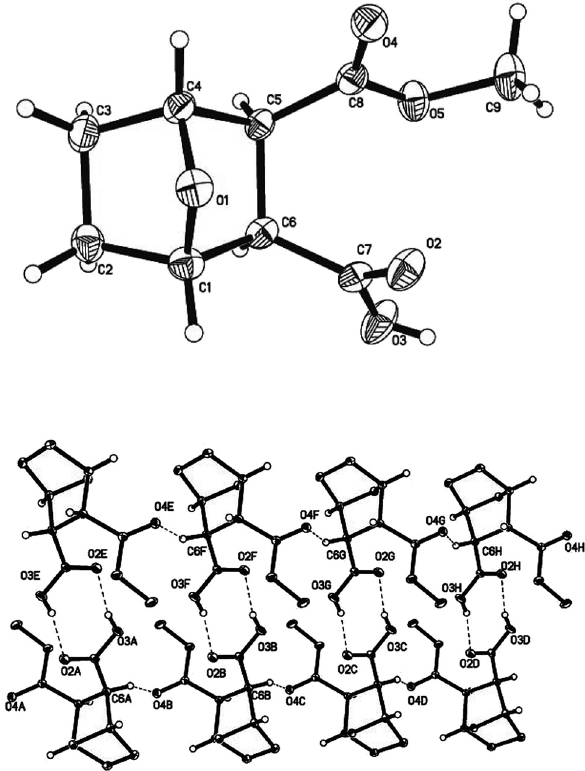
Table  : Data collection and